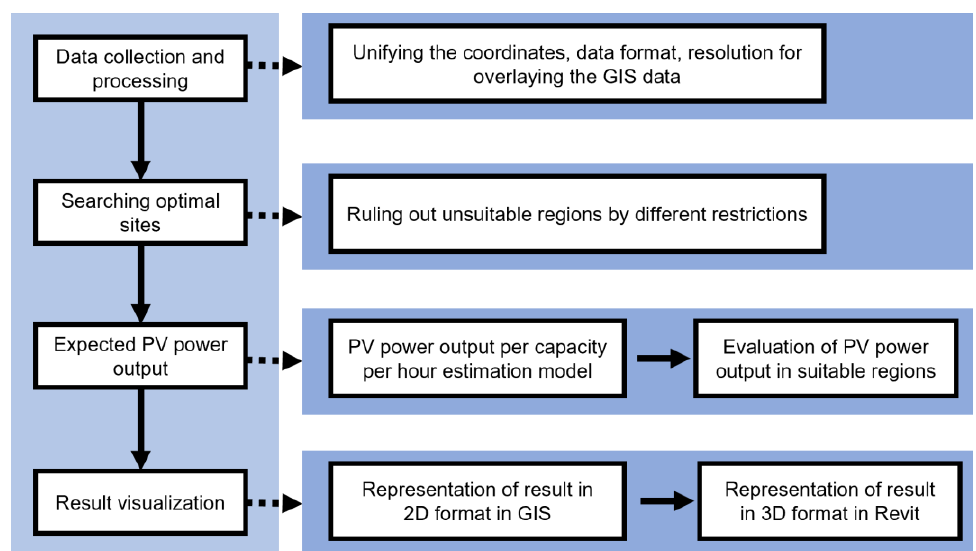
Figure 1. Four-step flowchart for selecting the sites of PV power plants.